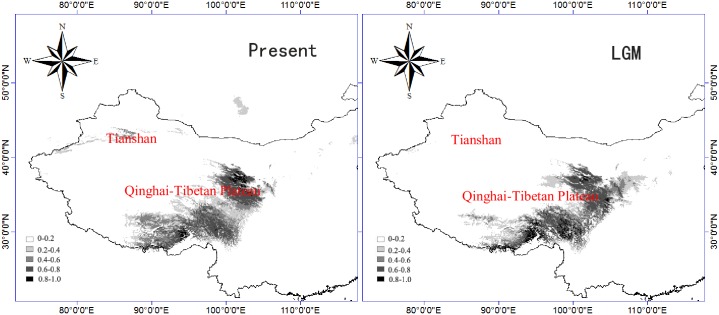
Potential distribution range for Pedicularis kansuensis under current climate conditions (left) and during the Last Glacial Maximum (LGM; right) based on the community climate system model (CCSM).